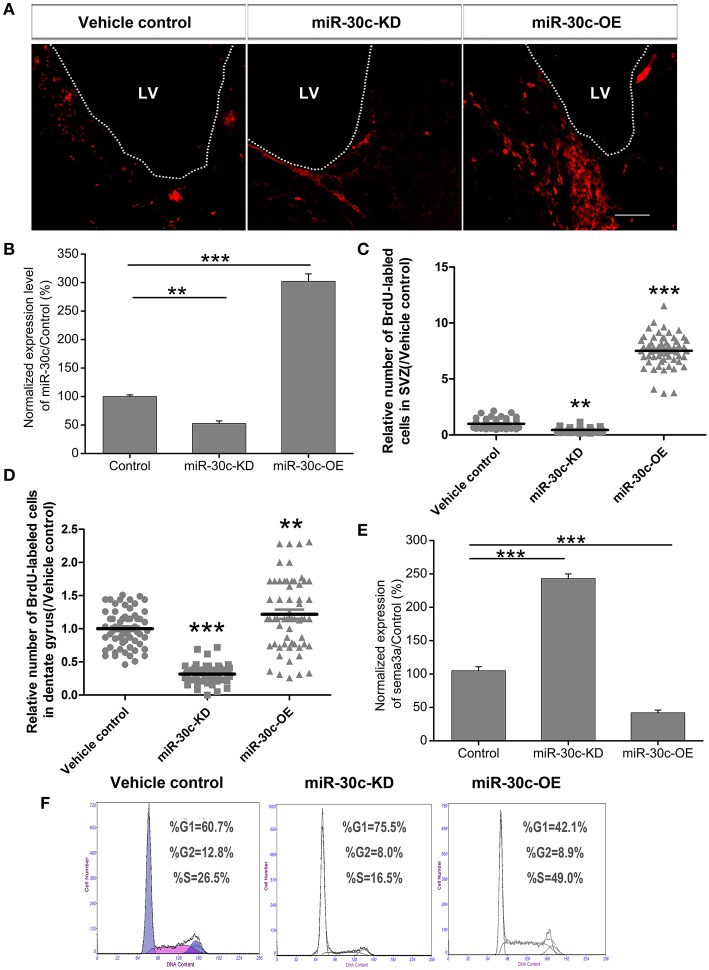
Effect of miR-30c on adult neurogenesis by negative regulation of semaphorin3A. (A) Representative images of newborn cells in the SVZ 4 h after intraperitoneal injection of BrdU. (B) Effects of miR-30c on adult neurogenesis. Expression of miR-30c was detected by qRT-PCR after cells sorted by fluorescence activating cell sorting (FACS), n = 8 mice/group. (C) Statistic analysis of BrdU-labeled newborn cells in the SVZ, 3 weeks after stereotaxic injection, n = 60 sections, four mice/group. (D) Statistic analysis of BrdU-labeled newborn cells in the DG, 3 weeks after stereotaxic injection, n = 60 sections, four mice/group. (E) Expression of semaphorin3A was detected by qRT-PCR. Data in (B,E) were analyzed by one-way ANOVA, **p < 0.01 and ***p < 0.001 were determined by Bonferroni multiple comparison tests. Data in (C,D) were normalized to the average value of the control and analyzed by one-way ANOVA, **p < 0.01 and ***p < 0.001 were determined by Dunnett T3 multiple comparison tests. (F) Cell-cycle assessment by flow cytometry, n = 3 wells/group.